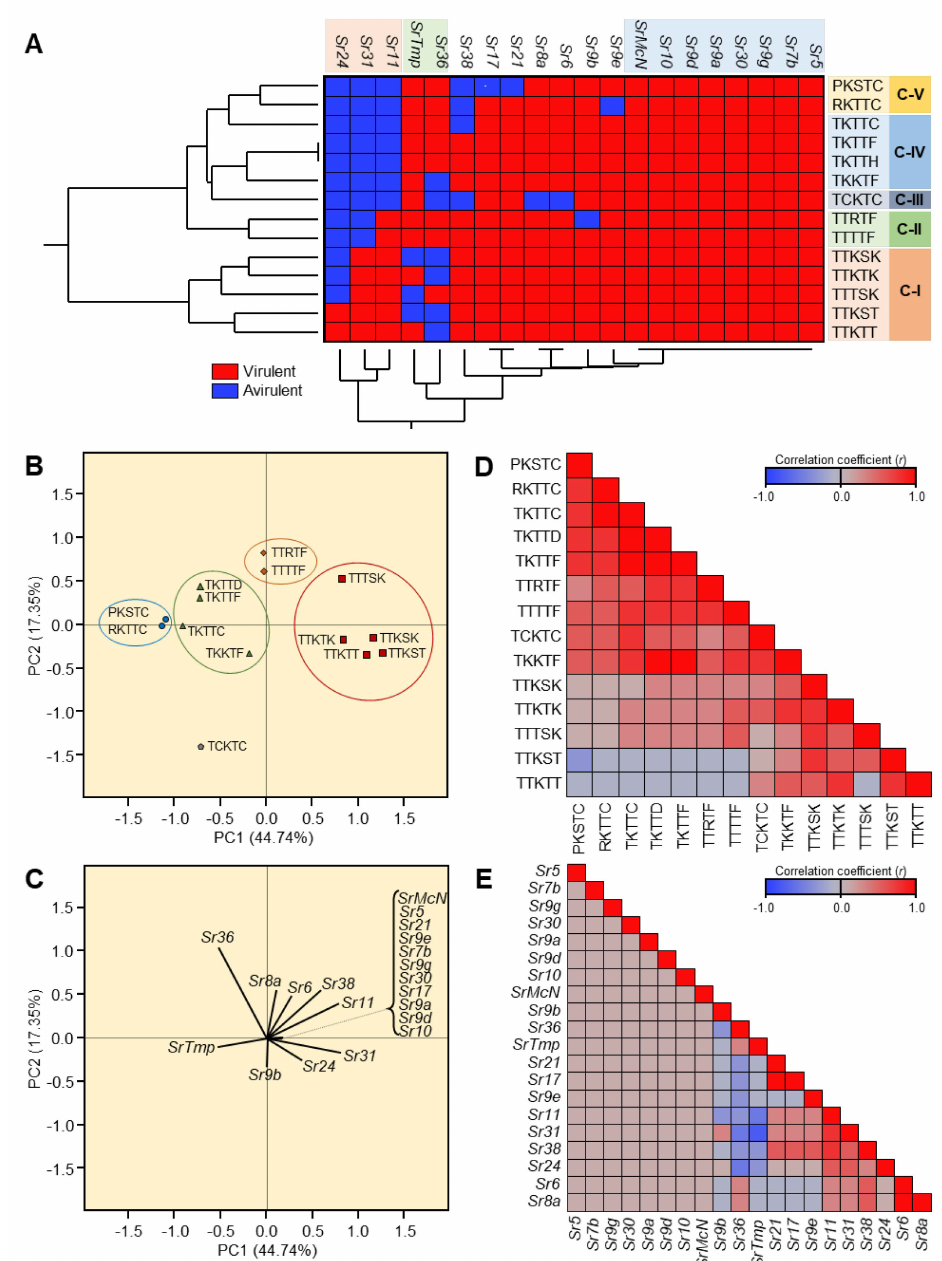
Figure 5. Two-way hierarchical cluster analysis (HCA) and principal component analysis (PCA) of virulence formula of 14 newly emerged races of Puccinia graminis f. sp. tritici in Africa, Asia, and Europe on 20 stem rust differential lines. ( A ) Two-way HCA is based on the virulence formula of the 14 races of P. graminis tritici on 20 stem rust differential lines. The heatmap diagram depicts the virulence of P. graminis f. sp. tritici races, with red representing virulent reactions and blue representing avirulent reactions. Individual races are represented by rows, whereas monogenic lines are represented by columns. PCA-related scatter plot and loading plot ( B , C ). Correlation investigation between different races and 20 stem rust differential lines ( D , E ). The heat map diagram depicts the correlation coefficient (r). Positive correlation coefficients ( r ) are highlighted in red, whereas negative correlation coefficients ( r ) are highlighted in blue (see the scale at the upper right corner of the heat